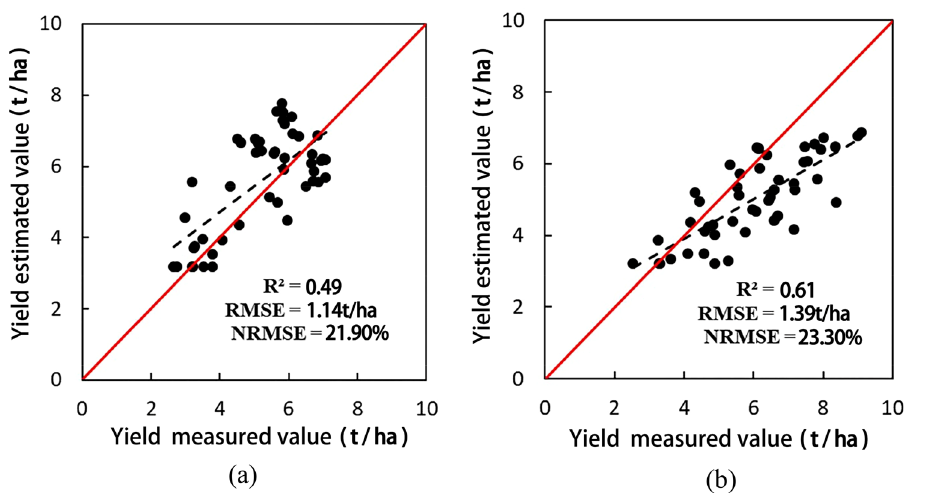
Figure 7. Scatter plots of the estimated and measured production values for 2014 ( a ) and 2015 ( b